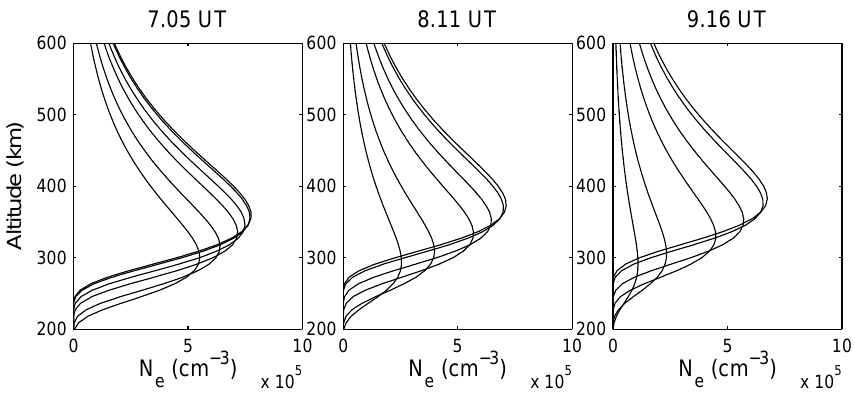
Fig. 7. Profiles of electron density about 1, 2, and 3h into the simulation for constant downward velocities. The profiles with the lowest densities correspond to the highest downward velocities.